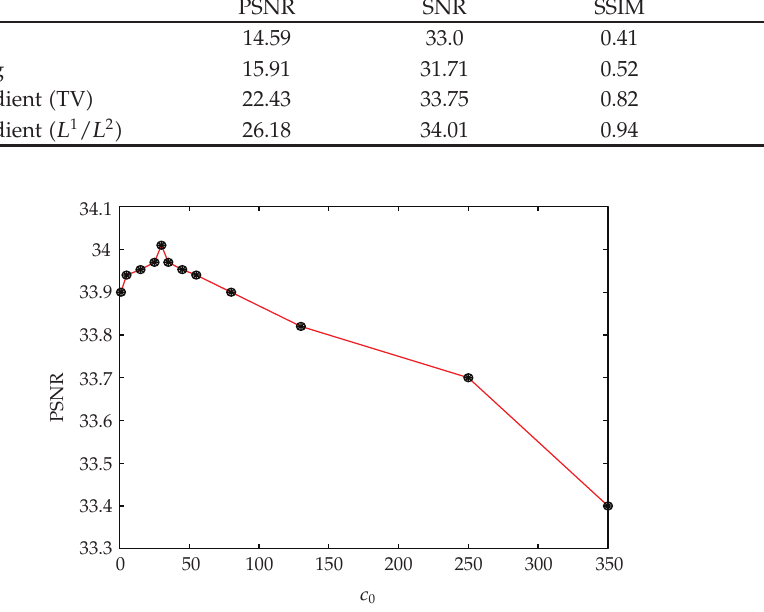
Figure 6: Evolution of the PSNR (cid:7) in dB (cid:8) of the reconstructed image by the topological gradient method, as a function of the level of the regularization coe ffi cient c 0